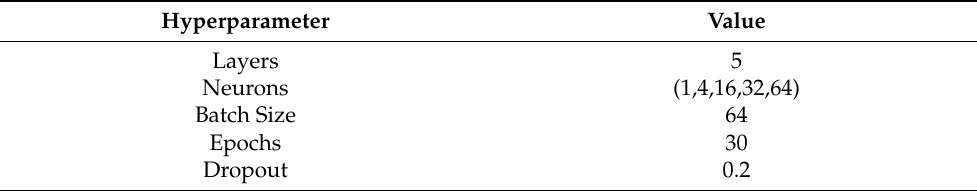
Table 1. Hyperparameters of the neural network.